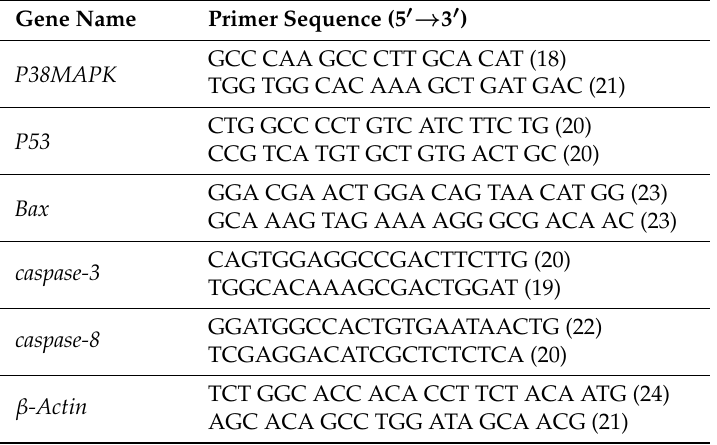
Table 2. Primer sequences of the genes used in this